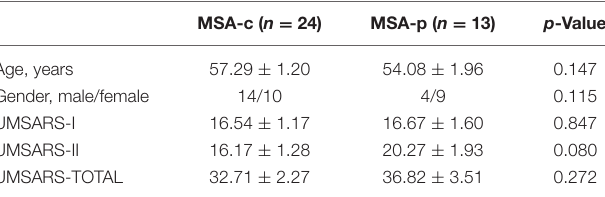
Frontiers in Aging Neuroscience |